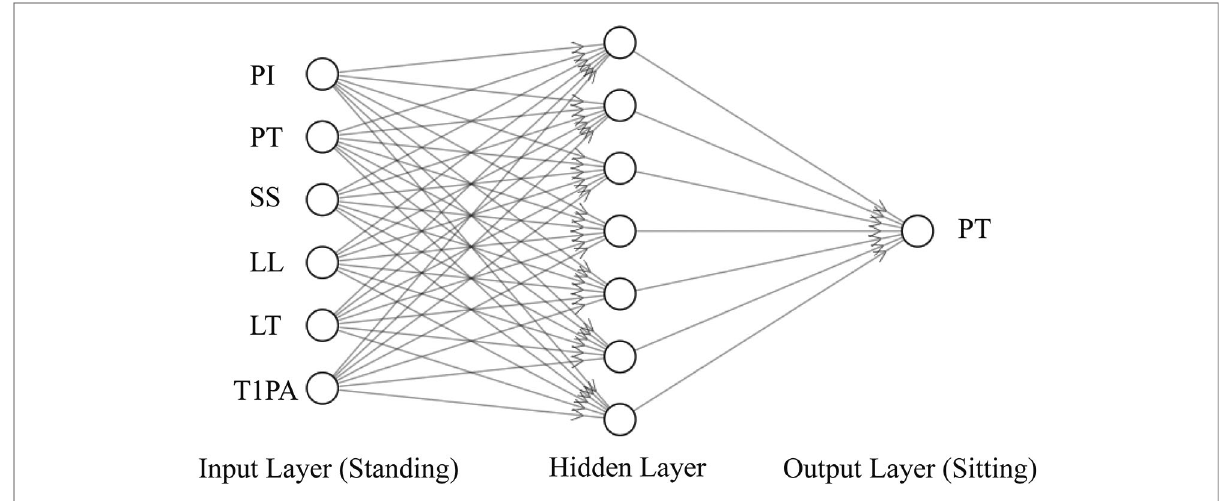
FIGURE 2 The BPNN framework for predicting the sitting PT with the standing parameters related to the sitting PT as input.